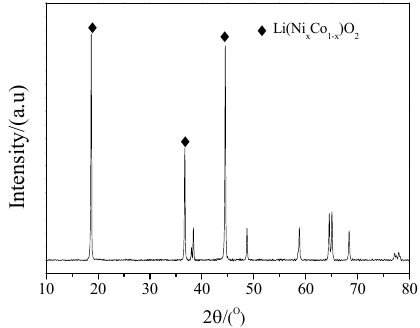
Figure 3. XRD patterns of the spent cathode active materials.